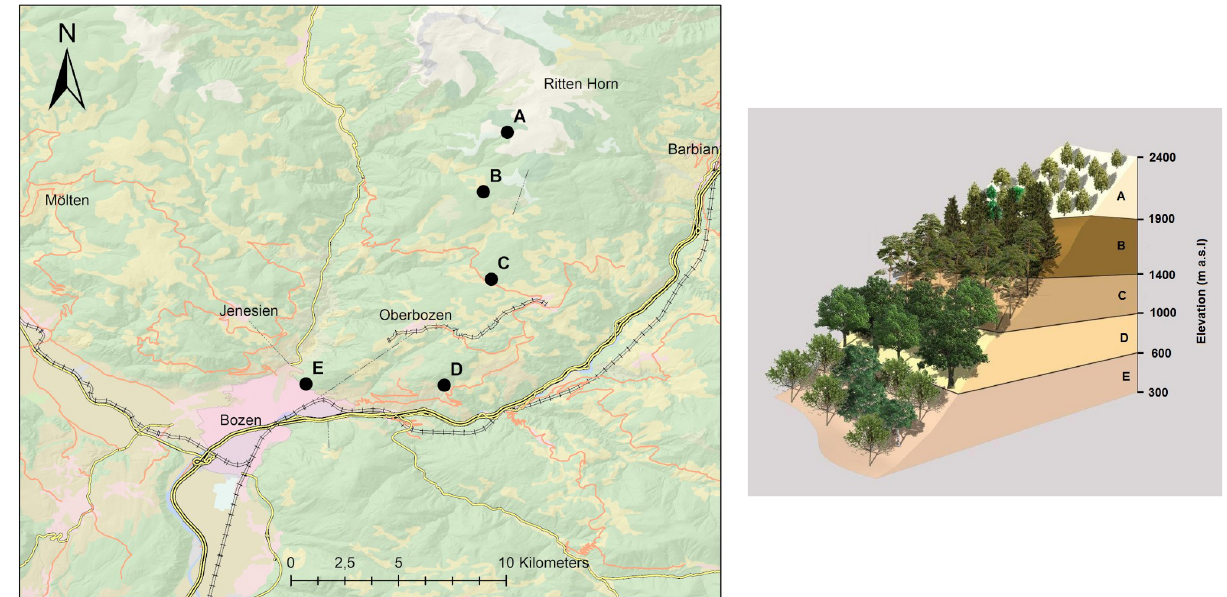
Fig 1. (a) Map showing study sites (b) Scheme of vegetation along the elevation